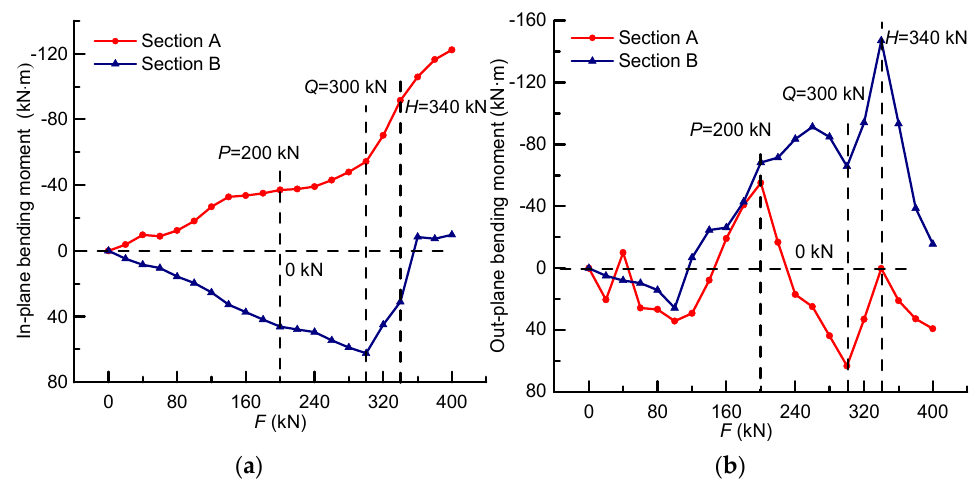
Figure 12. The changing characteristics of the bending moment: ( a ) the constructed in-plane bending moment based on the expanded stress data; ( b ) the constructed out-plane bending moment based on the expanded stress data.